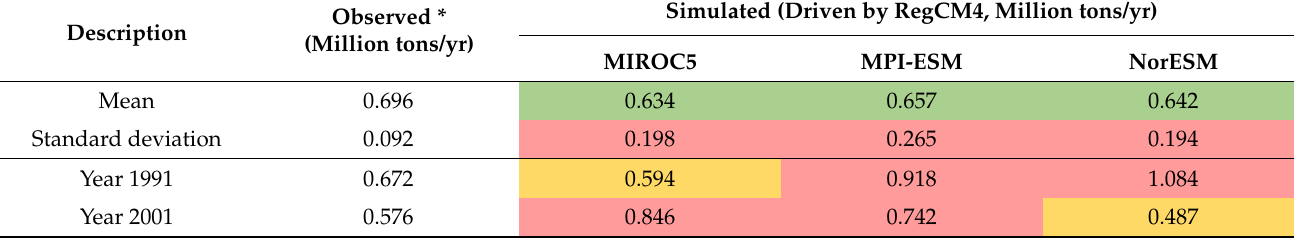
Table 3. Comparison of observed and simulated annual sediment loads at Kalu River Basin outlet for 1991–2005. “Green, and red” represent the simulated streamflow value within ± 10%, and beyond ± 20% of observed streamflow, respectively. * Observed data are available only for four years (1976, 1984, 1991, and